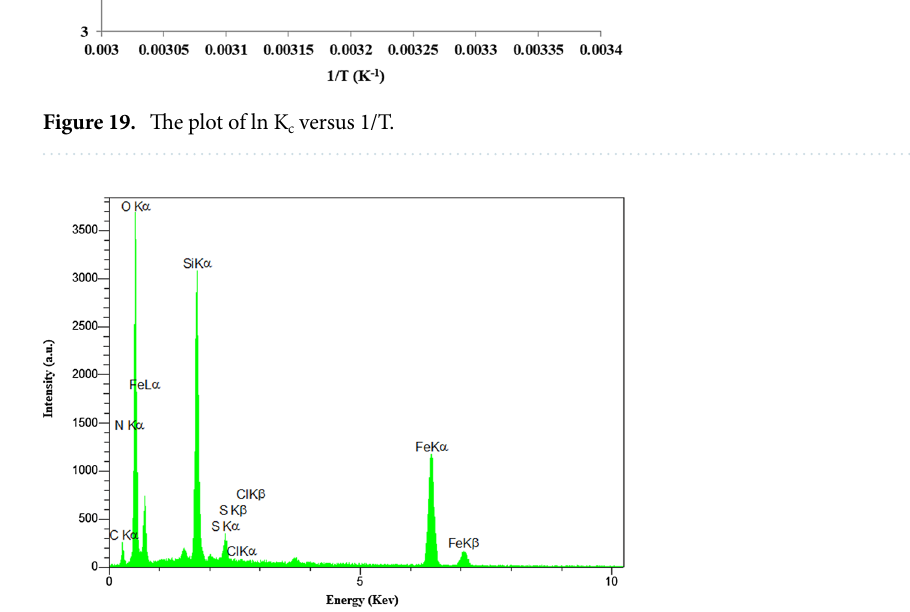
Figure 20. The EDS analysis of Fe 3 O 4 @Void@m.SiO 2 nanomaterial after MB